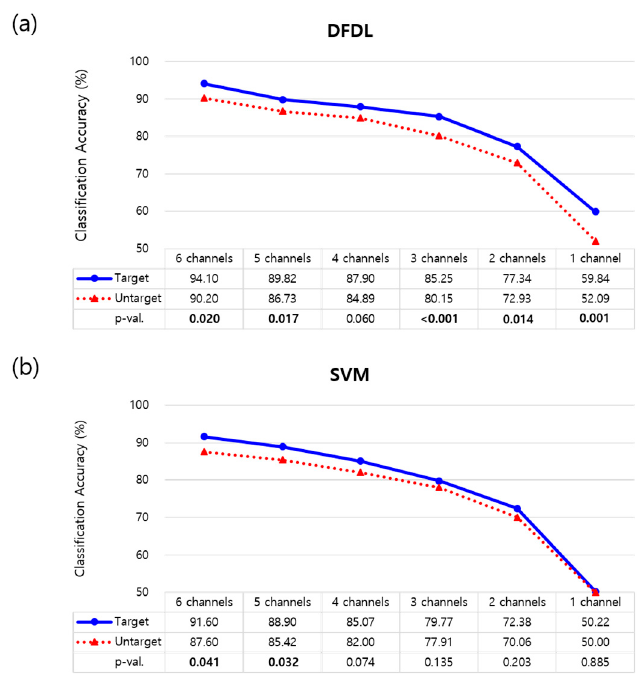
Figure 5. Comparison of the targeted and untargeted method. ( a ) The targeted method showed higher classification accuracy than the untargeted method with statistical significance in every number of channels except 4 channels in DFDL. ( b ) However, the targeted method was superior to the untargeted method only when using 5–6 channels in SVM. Bold values indicate significant differences.